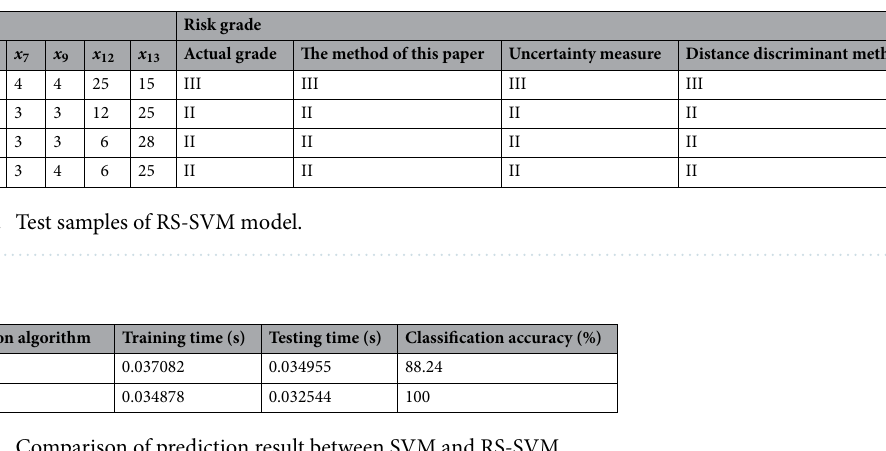
Table 6. Comparison of prediction result between SVM and RS-SVM.